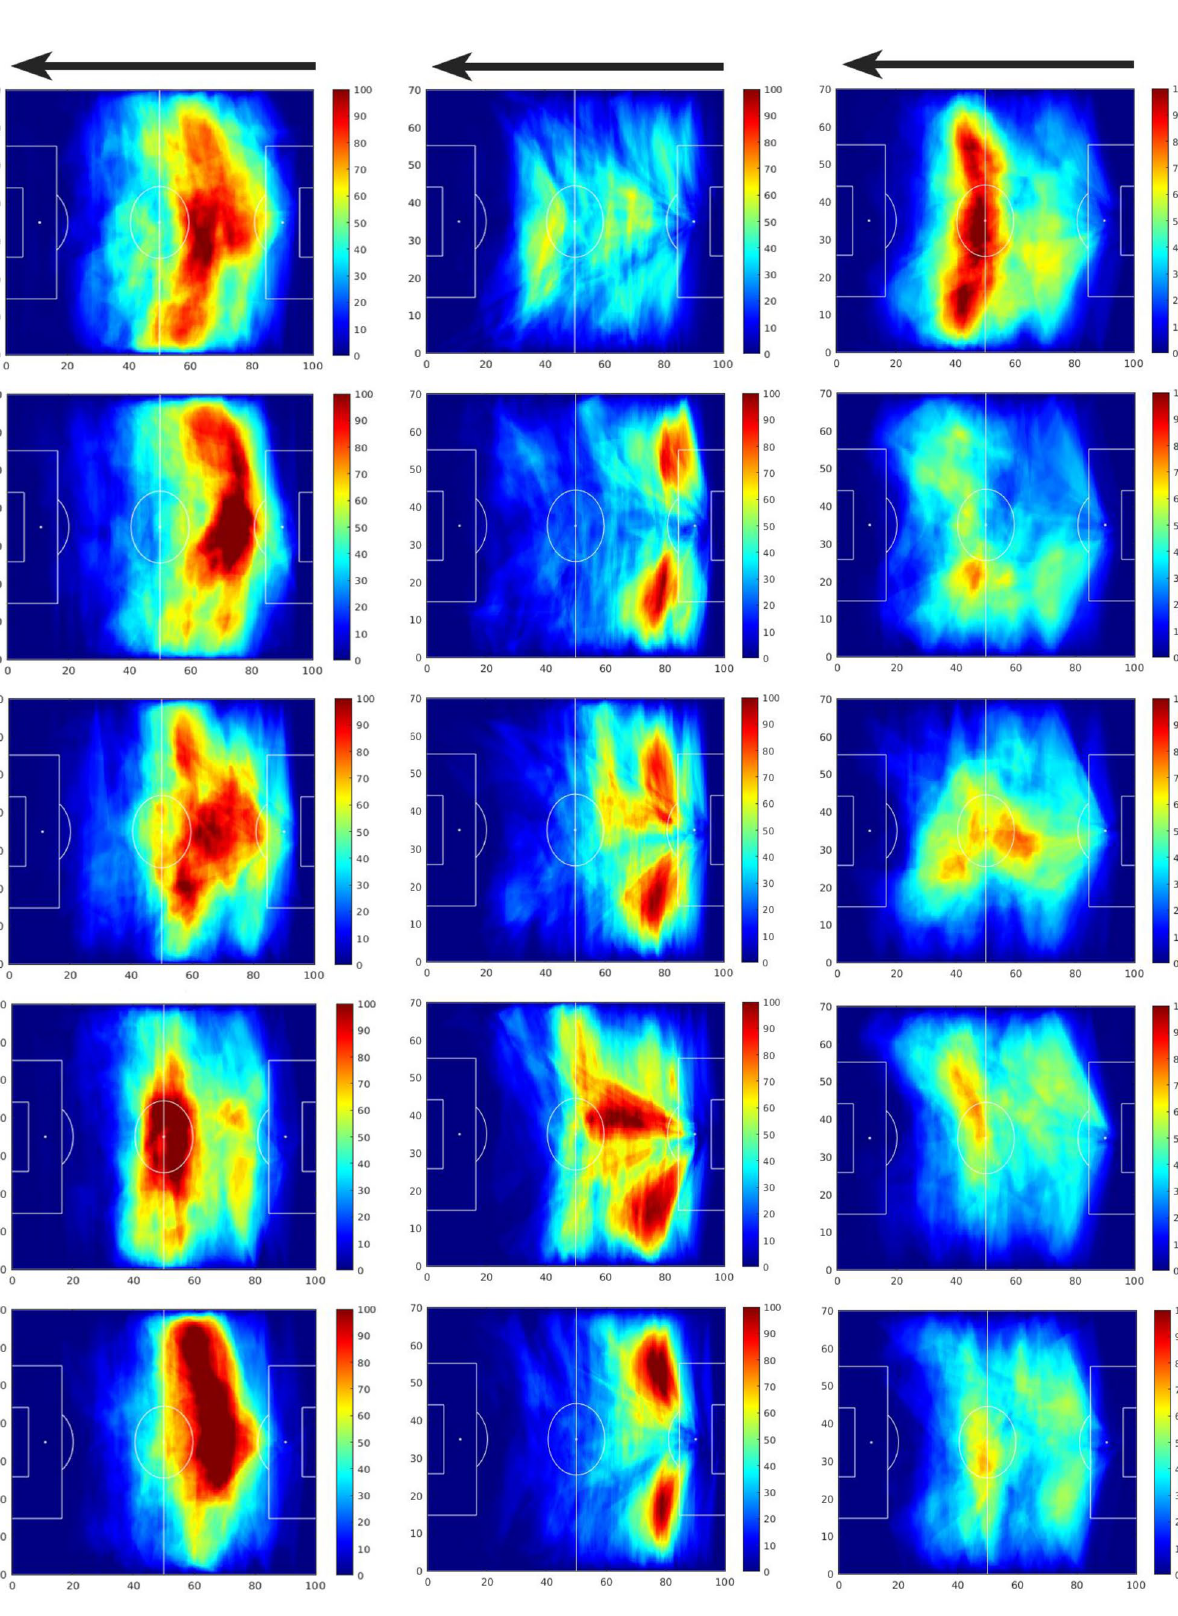
Figure 2. Landscape of passing opportunities for penetrative (left), support (middle), and backward (right) of the five matches. Darker blue indicates areas of the field that did not have any passing opportunities available in the course of the match, while colors nearer to dark red indicate a higher amount of passing opportunities available on that area of the field. The black arrow on the top indicates the attacker